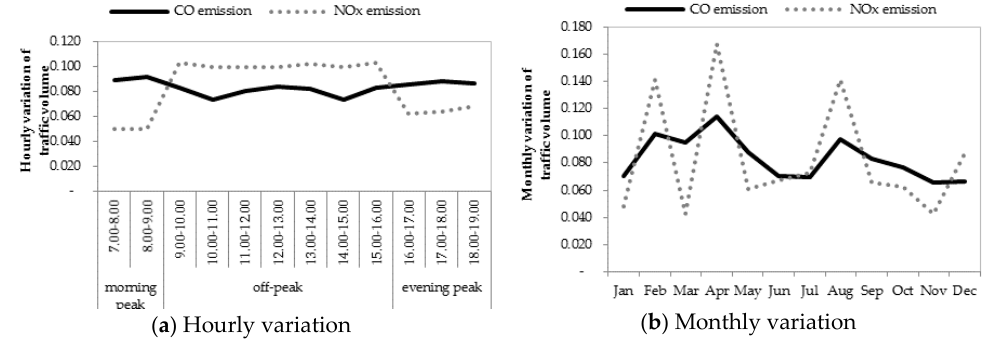
Figure 13. Temporal variation of CO and NO X emissions in the BMR, 2015: ( a ) hourly variation; ( b ) monthly variation. ( b ) monthly